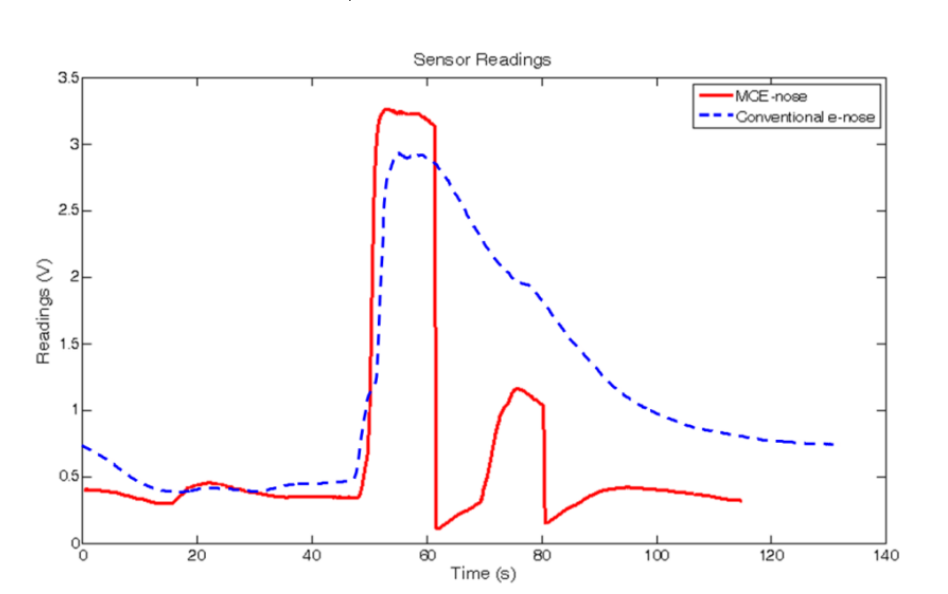
Figure 15. 2D comparison of the raw readings between a conventional e-nose (dashed blue) and the MCE-nose (solid red), when faced to two sources of different